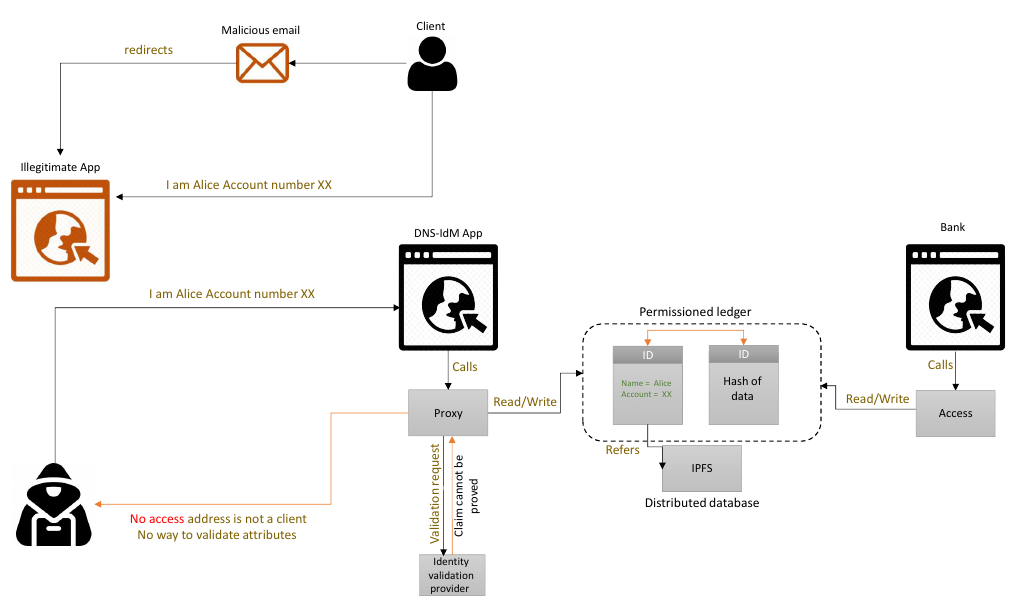
Figure 6. Attempted phishing attack on the DNS-IdM